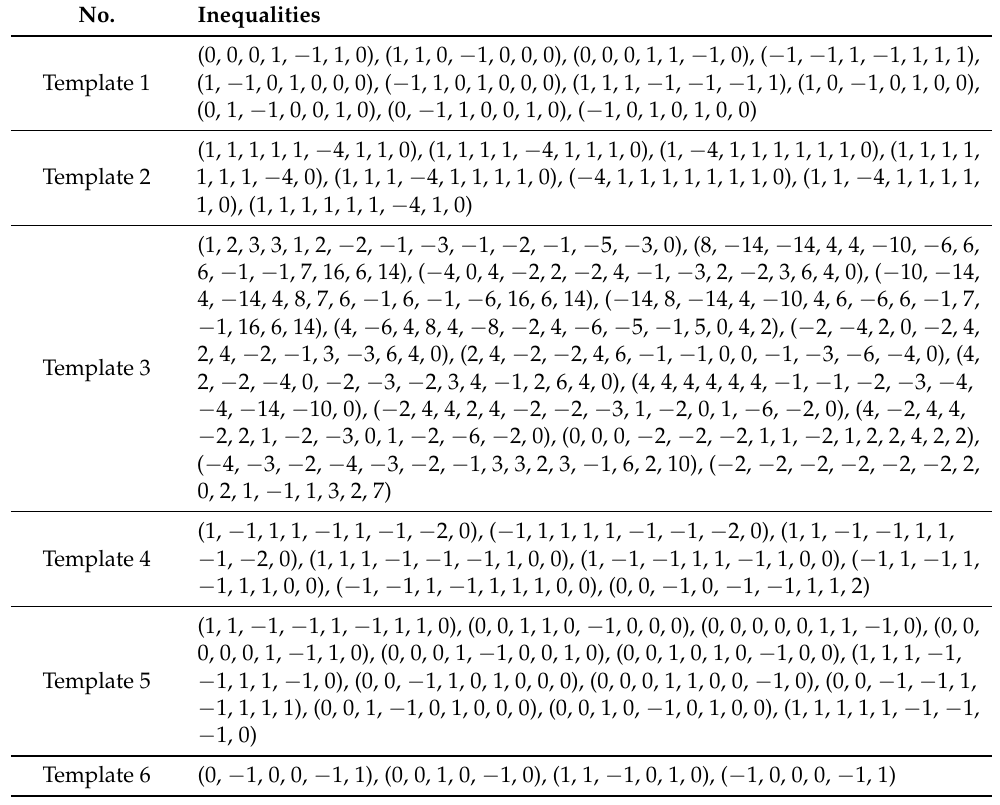
Table A3. Inequality templates used in the MILP model to search for mixture differential distinguishers.